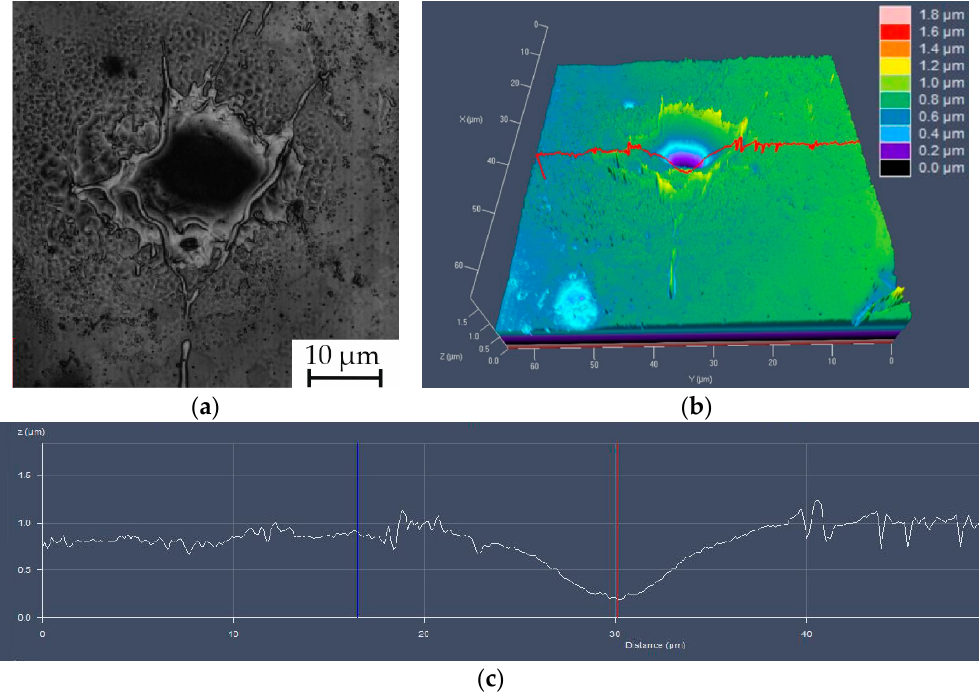
Figure 5. Confocal imaging and analysis of the laser irradiation depth: ( a ) image of single laser irradiation area; ( b ) Z-stack 3D reconstruction of the surface morphology of the single spot with range indicator; ( c ) topography profile traversing single irradiation area.